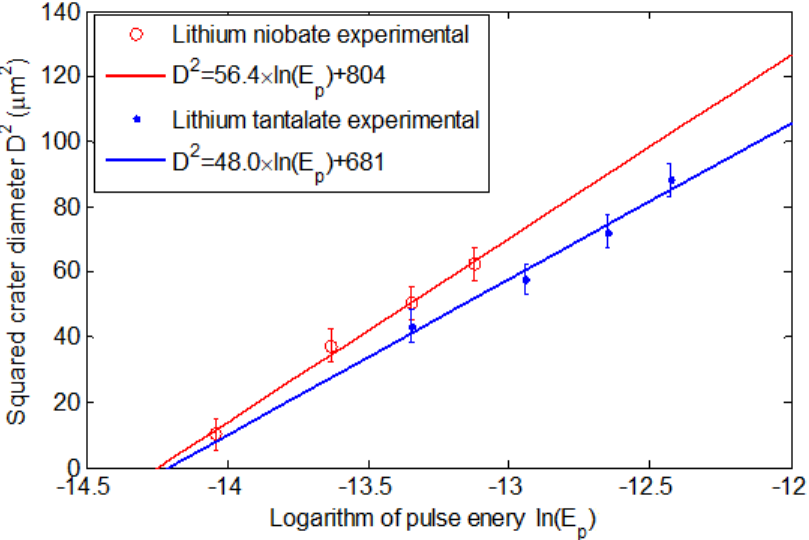
Figure 2. Evolution of the square of the crater diameter in relation to the logarithm of pulse energy, consistent with Equation (1).